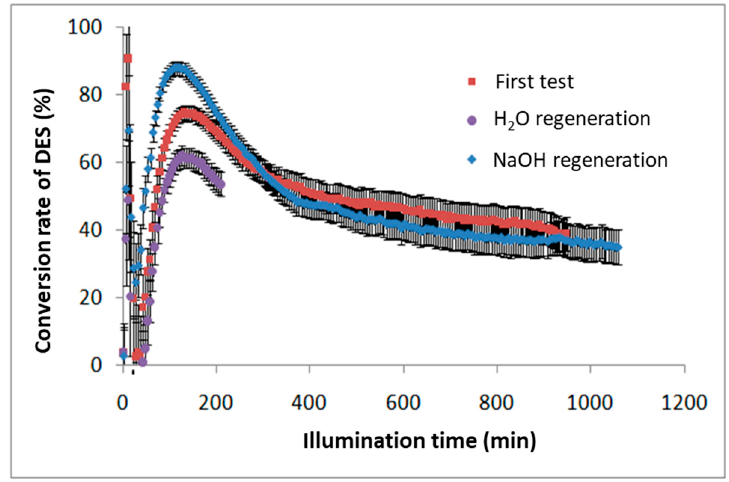
Figure 11. Photo-oxidation of DES with 8% Ta-TiO 2 /PEG immobilized on β -SiC foams before and after regeneration with H 2 O and NaOH.